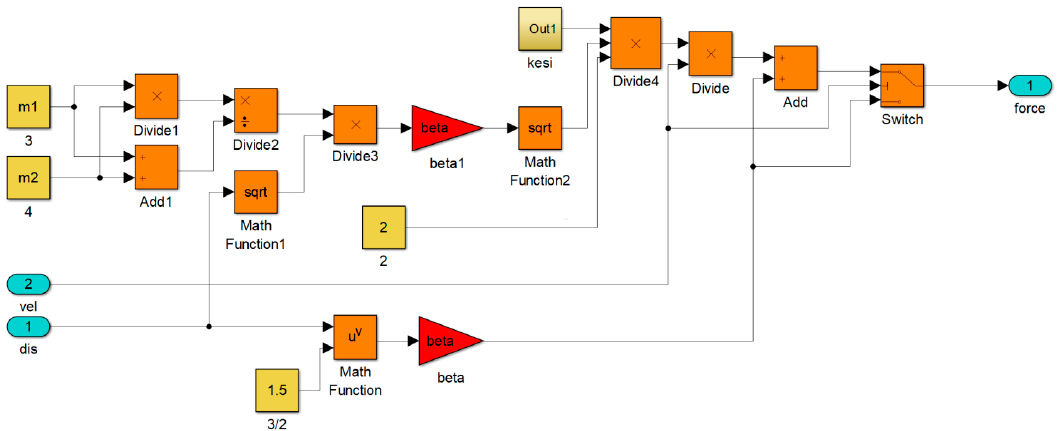
Figure 4. Pounding force model established in MATLAB/Simulink.